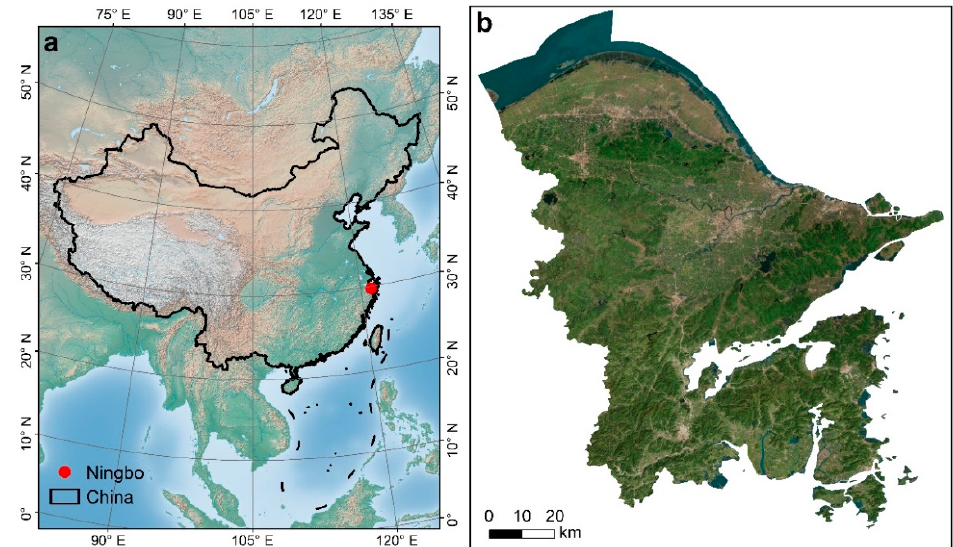
Figure 3. The study area of Ningbo. ( a ) Its geographical location in China. ( b ) High-resolution satellite image of Ningbo.